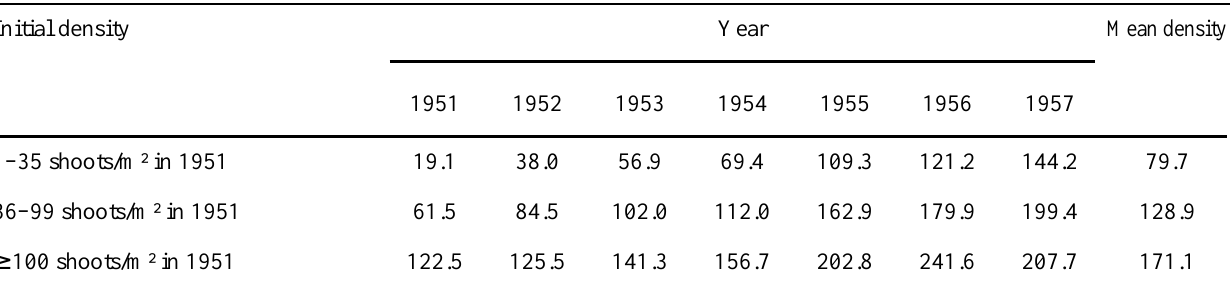
Table 2. Changes in the density of leafy spurge (shoots/m²) during 1951–1957 according to the intial density (Selleck et al.